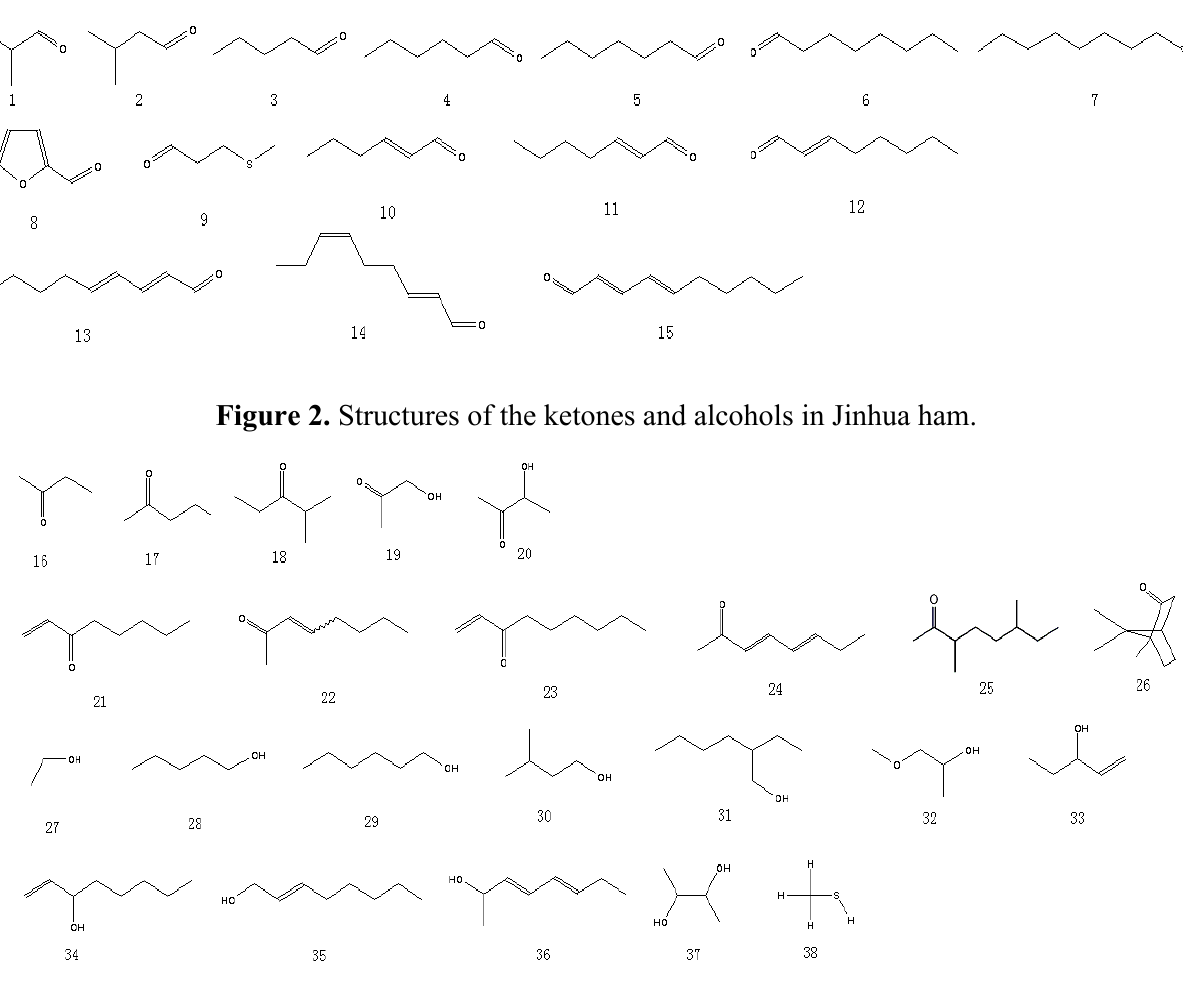
Figure 1. Structures of the saturated and unsaturated aldehydes in Jinhua ham.